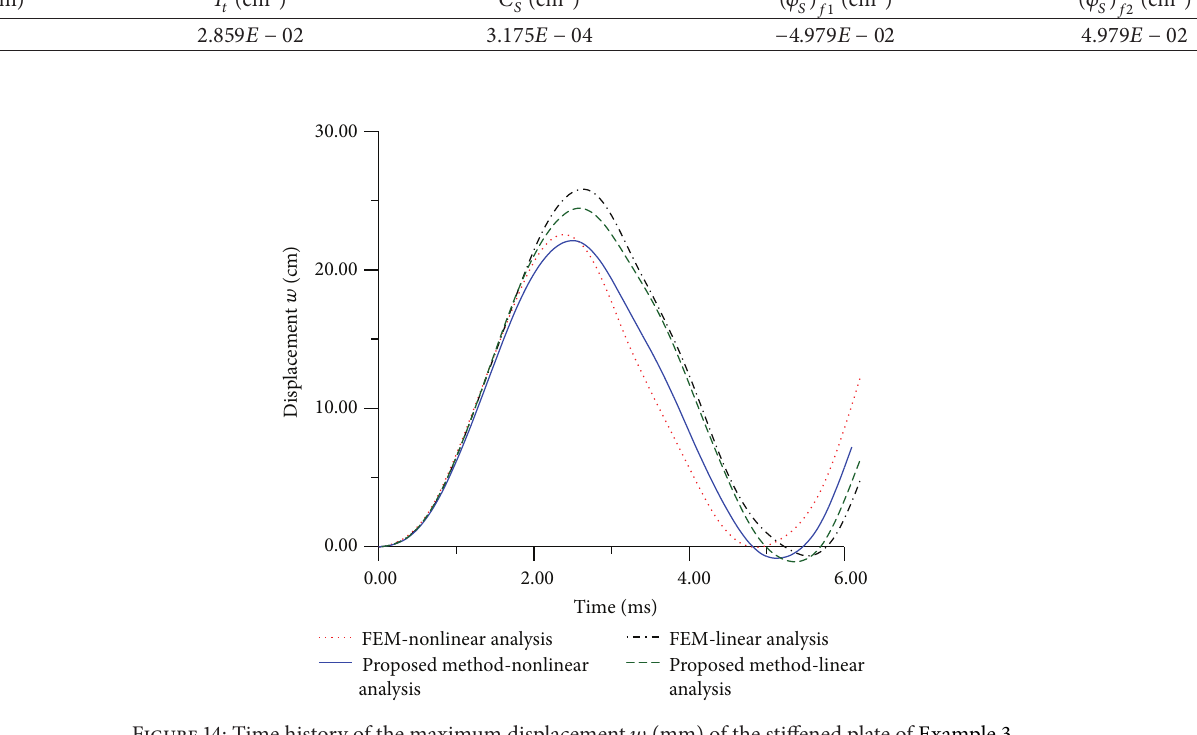
Figure 14: Time history of the maximum displacement 𝑤 (mm) of the stiffened plate of Example 3.